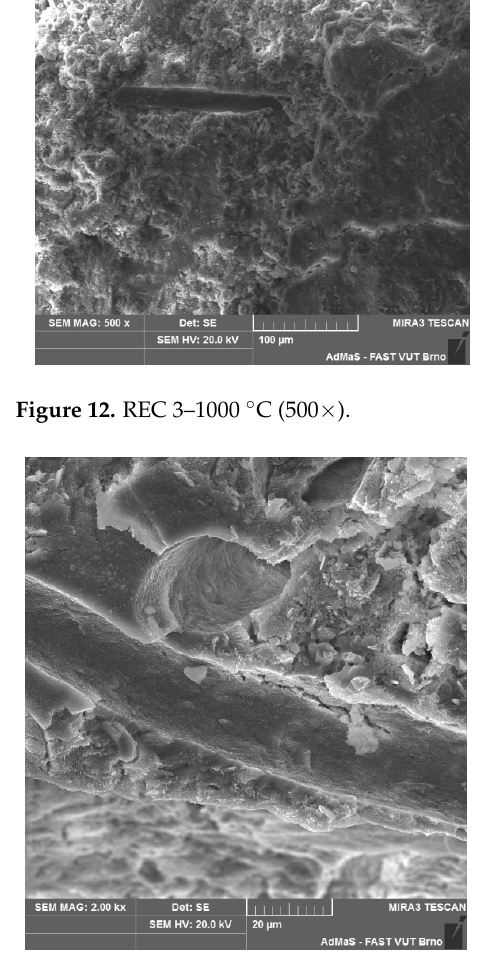
Figure 13. REC 3–1000 °C (2000×).